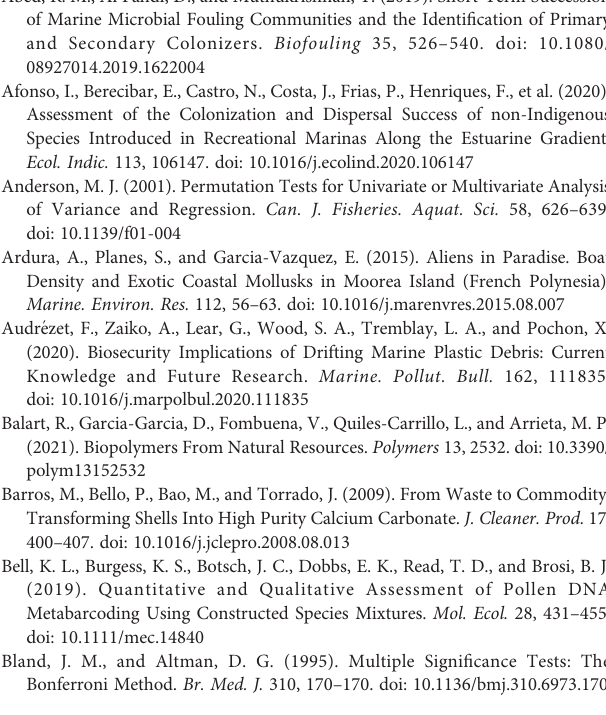
Supplementary Table 2 | Alpha diversity measures (ASV number and Shannon index) between subgroups “ Sampling week ” for bacterial (top) and eukaryotic (bottom) datasets.